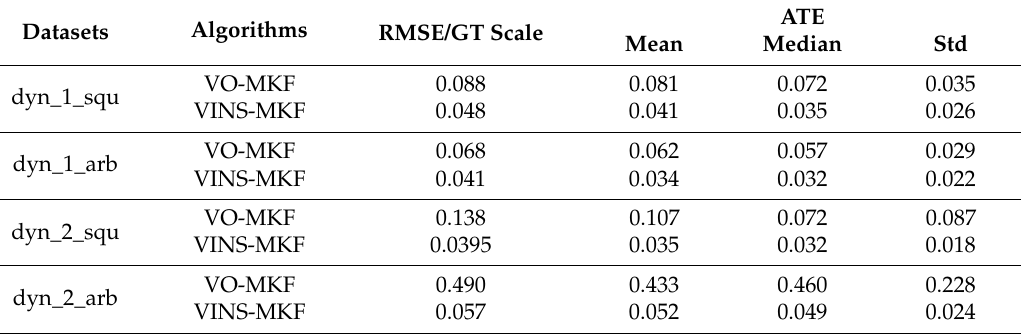
Table 3. The root mean square error (RMSE/m) and absolute trajectory error (ATE/m) results of VO-MKF and VINS-MKF on dynamic